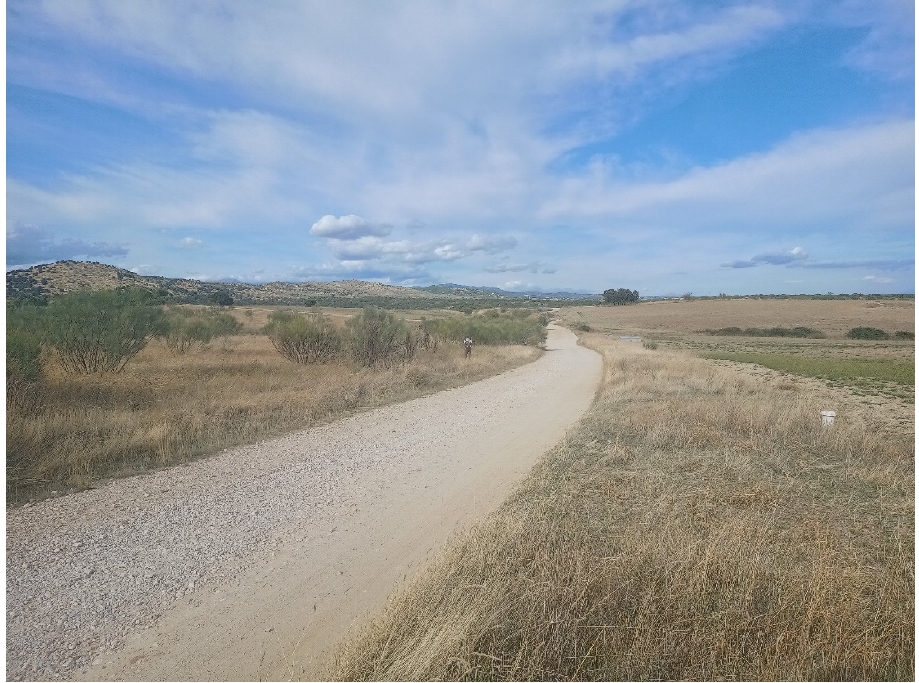
Figure 1. A drove road crossing croplands in Madrid Region. Note the extent of unploughed land and the development in it of permanent grasslands with Retama spaerocarpa shrubs.